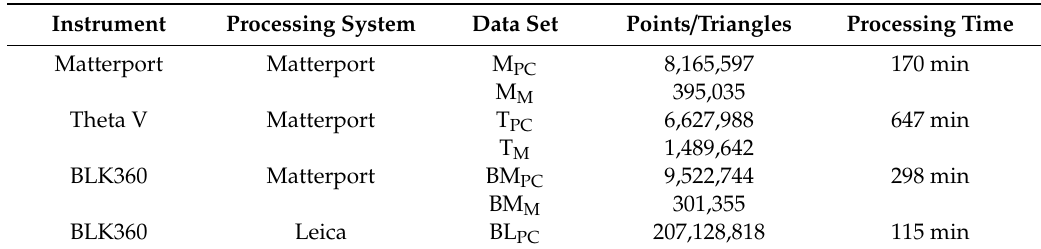
Table 3. Point and triangle counts for the obtained point clouds and meshes of the Tetra test site, and the processing time required to obtain them.